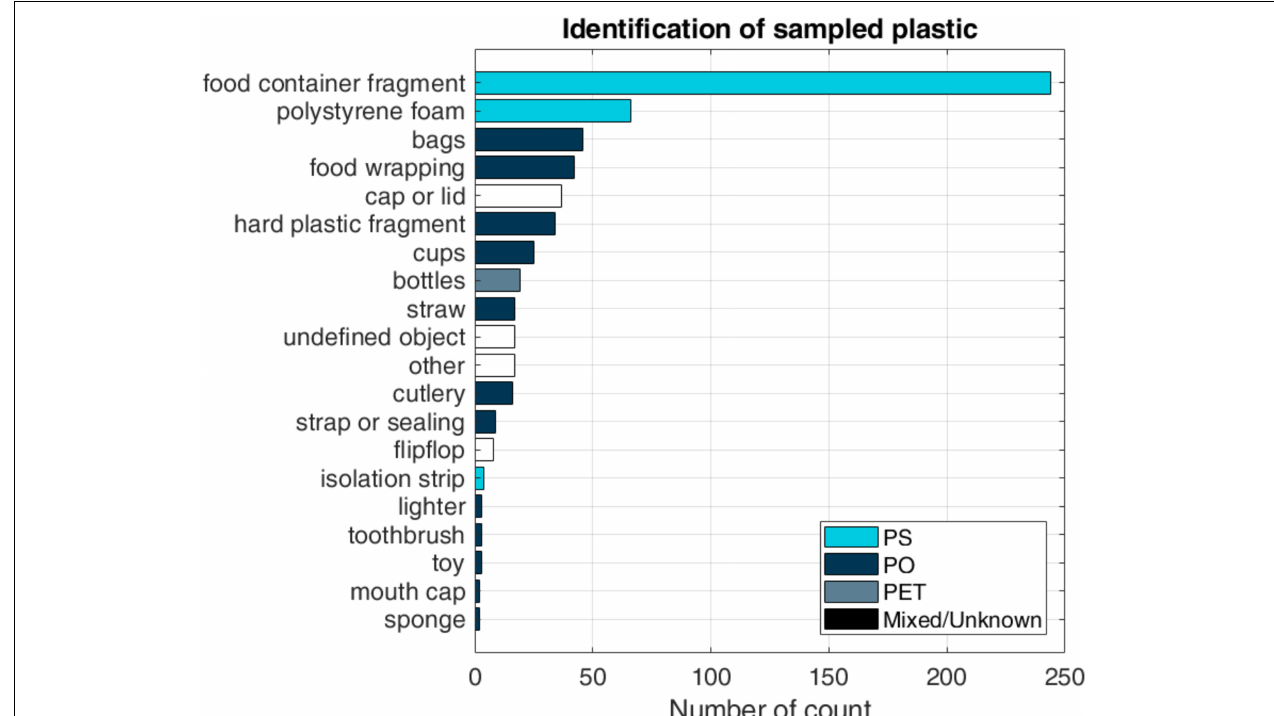
FIGURE 5 | Plastic pieces identification of the 614 analyzed plastic pieces, including plastic composition.